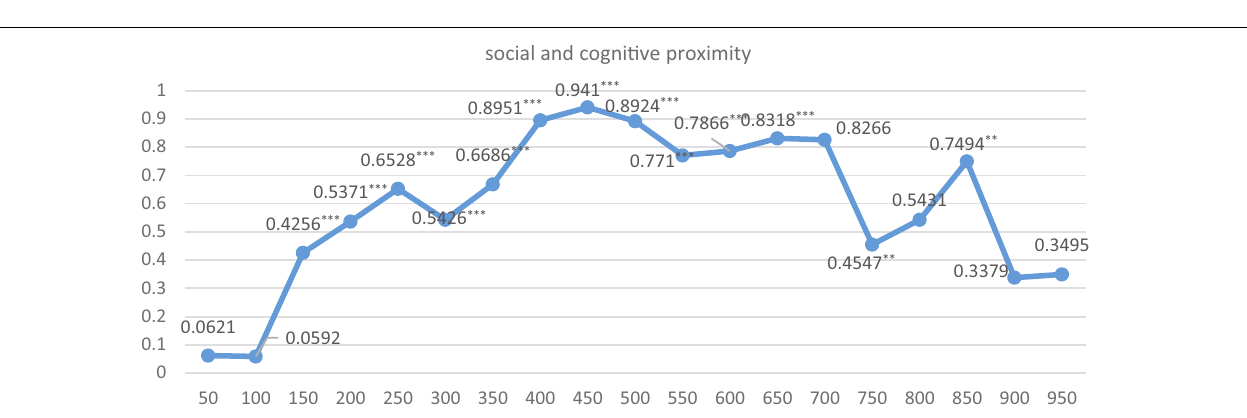
FIGURE 6 | The regression results under geographic and cognitive weight matrix with different kilometers. ***, **, and * indicate that the significance level is at the 1%, 5%, and 10%, respectively.